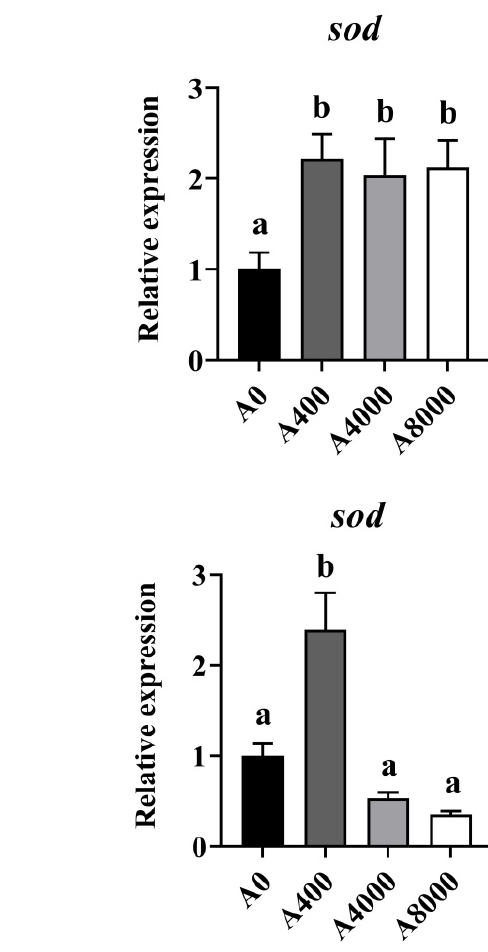
Figure 3. Effects of dietary AMP on expression of antioxidant-related genes in the liver ( A ) and intestine ( B ). gpx : glutathione peroxidase gene; sod : superoxide dismutase gene. Data are shown as mean ± SEM ( n = 6). Different lowercase letters represent significant differences among all groups ( p < 0.05).